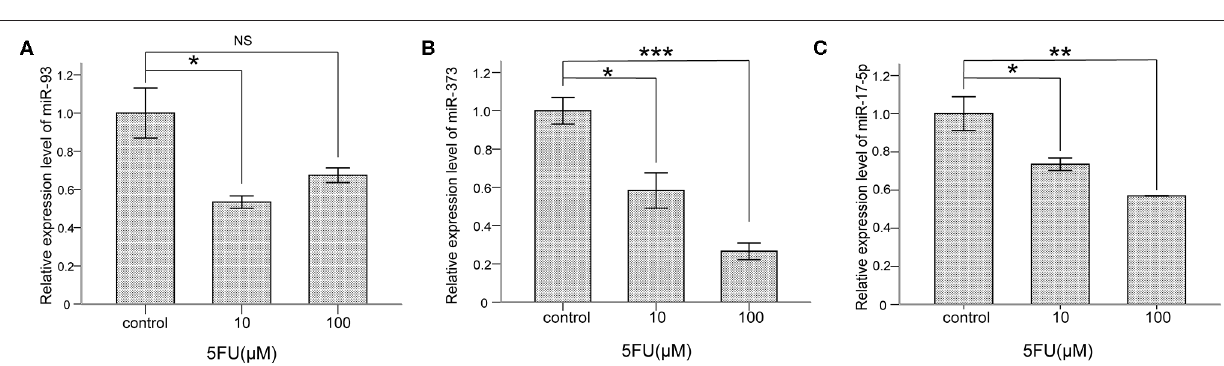
Frontiers in Oncology |